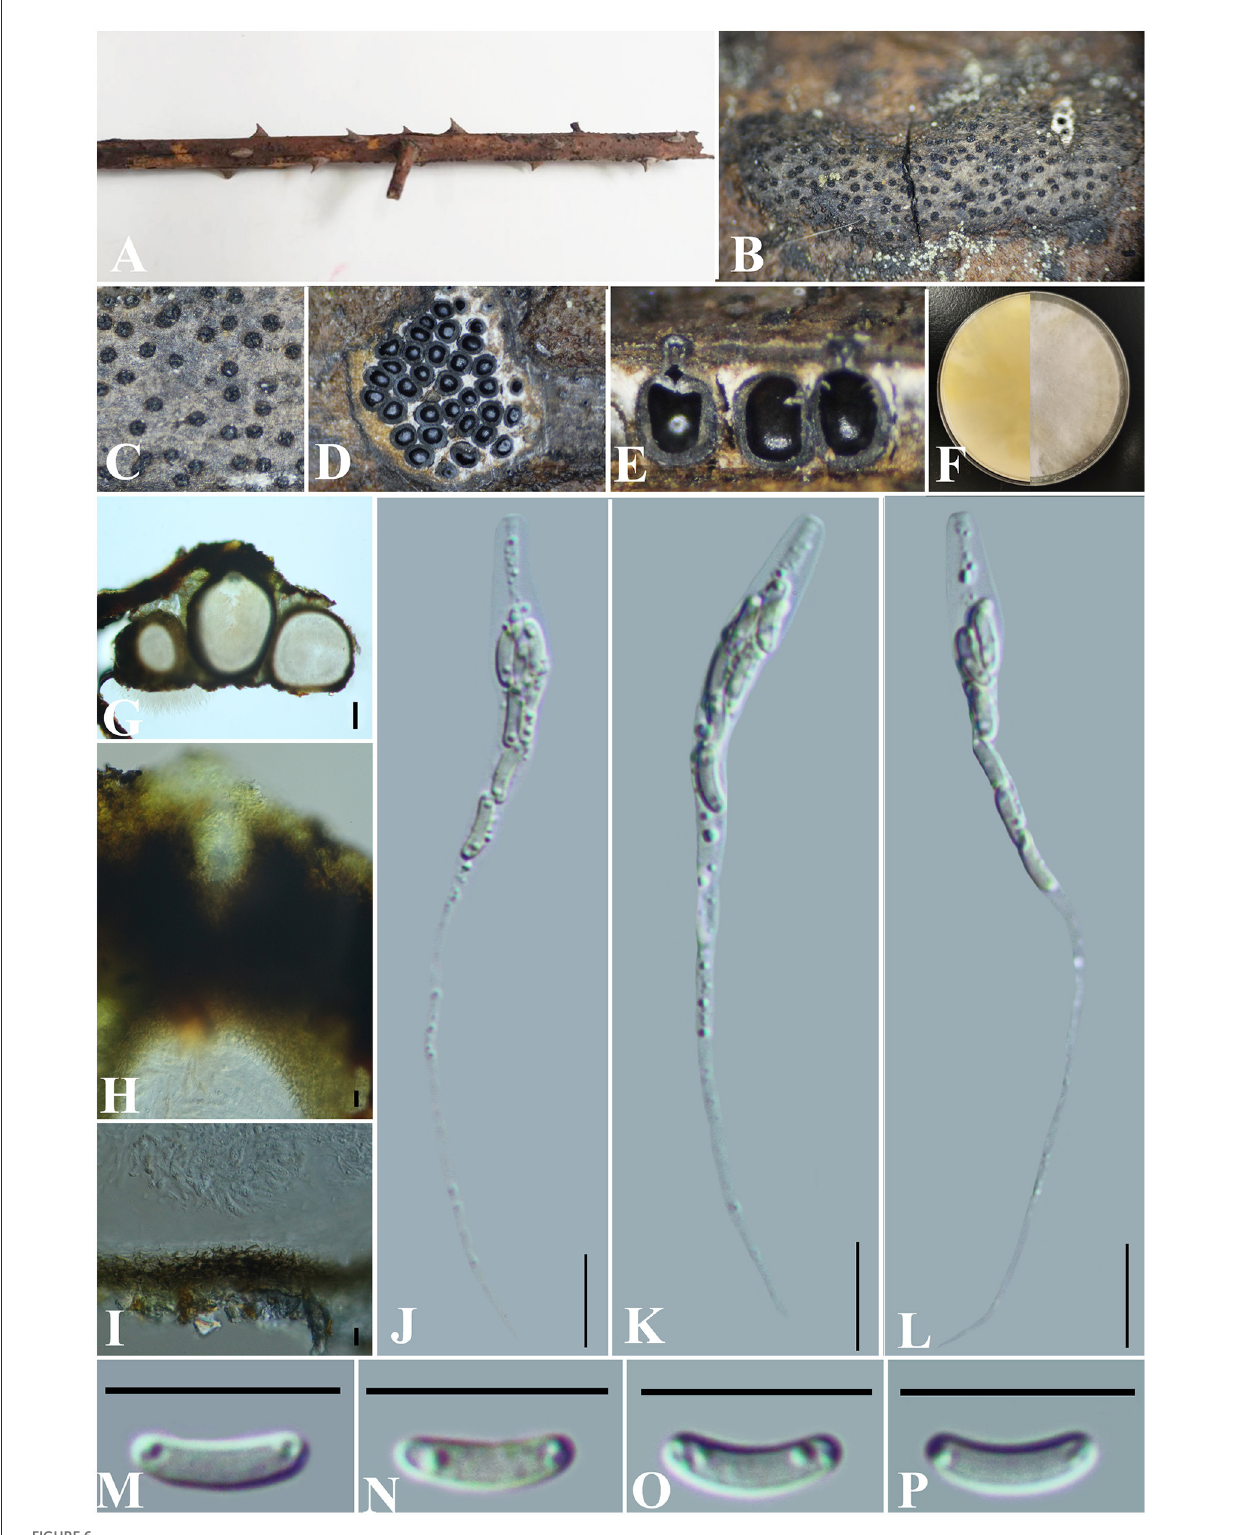
FIGURE6 Diatrype rubi (GMB0429, holotype). (A) Type material. (B, C) Close-up of stromata. (D) Transverse section through stromata. (E) Vertical section through stromata. (F) Culture on PDA. (G) Section through the ascostroma. (H) Ostiolar canal. (I) Peridium. (J–L) Asci. (M–P) Ascospores. Scale bars: (G) = 50 µ m; (H–P) = 10 µ